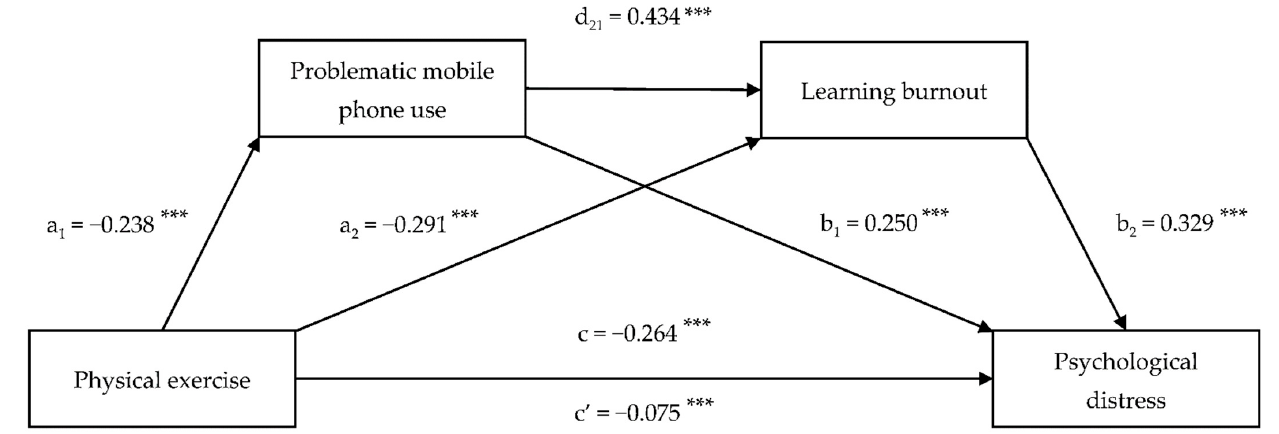
Figure 1. Serial multiple mediation model showing the association between physical exercise and psychological distress with problematic mobile phone use and learning burnout as mediators, adjusted for age, sex, and socioeconomic status. Standardized regression coefficients are presented. *** p <